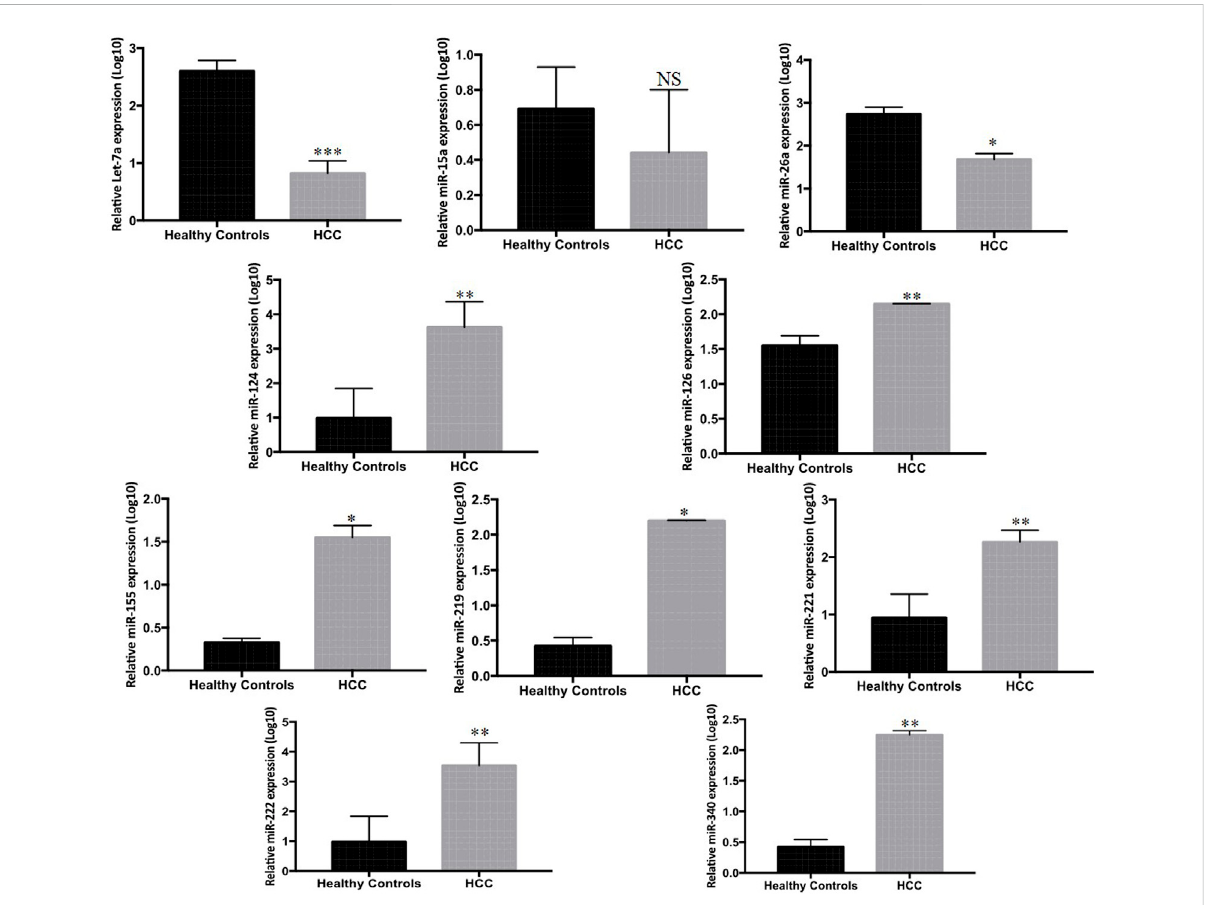
FIGURE 1 Differential expression of ten candidate miRNAs in sera of HCC patients ( n = 33) and HC ( n = 33) measured by Rt-qPCR. The statistical analysis was performed using Mann – Whitney test (GraphPad Prism 5.0). The statistically signi fi cant p -value was denoted as <